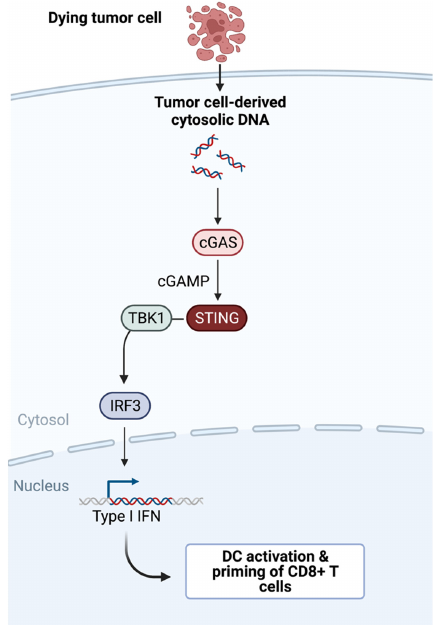
Figure 1. STING pathway : tumor-cell-derived DNA triggers the cGAS-cGAMP-STING signaling pathway and an innate immune response resulting in DC maturation and CD8+ T cell priming downstream of type I IFN production.